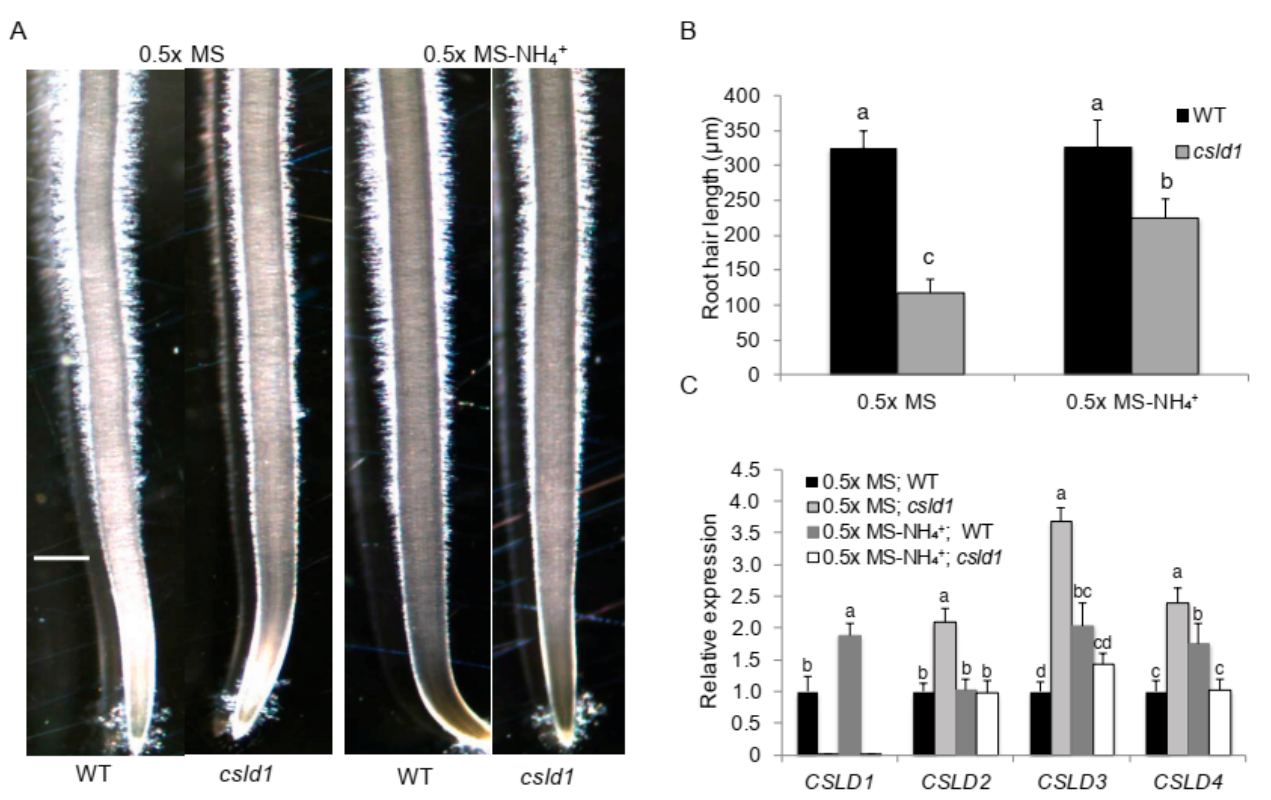
Figure 2. CSLD1 mutants showed reduction in root hair length and altered the expressions of CSLD 2/3 in the absence of NH 4+ . ( A ) and ( B ) Root hair length of WT and oscsld1 mutants in MS and modified MS medium without NH 4+ . ( C ) Relative expression of CSLD1 , CSLD2 , CSLD3 , and CSLD4 in WT and oscsld1 mutants in MS and modified MS medium without NH 4+ . Scale bars = 500 µ m. Bar graphs show mean values ± standard error of means ( n = 9). Different letters indicate significant differences between groups according to Tukey’s HSD test ( p < 0.05).